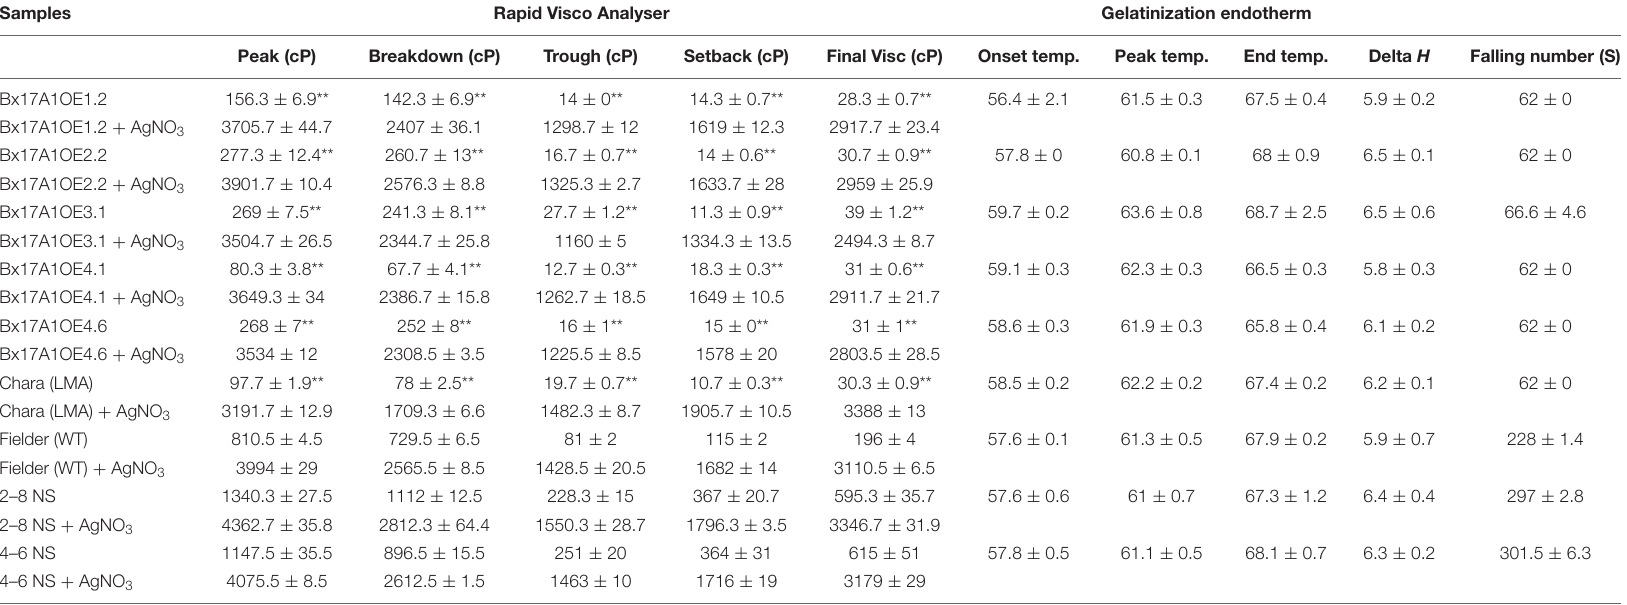
TABLE 1 | Rapid Visco Analyser (RVA) profile and gelatinization properties (DSC).